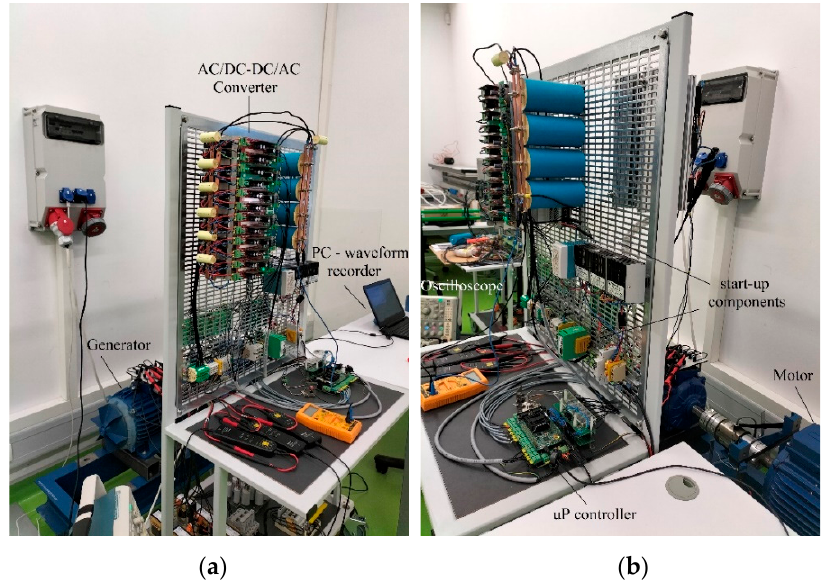
Figure 22. Experimental stand for testing of induction generator system (Figure 9): ( a ) left side view, ( b ) right side view.